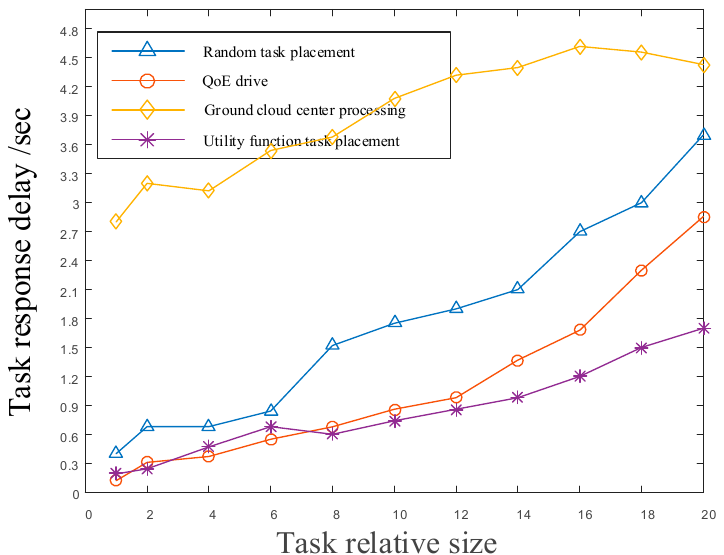
Figure 11. The delay performance comparison of different task placement strategies.